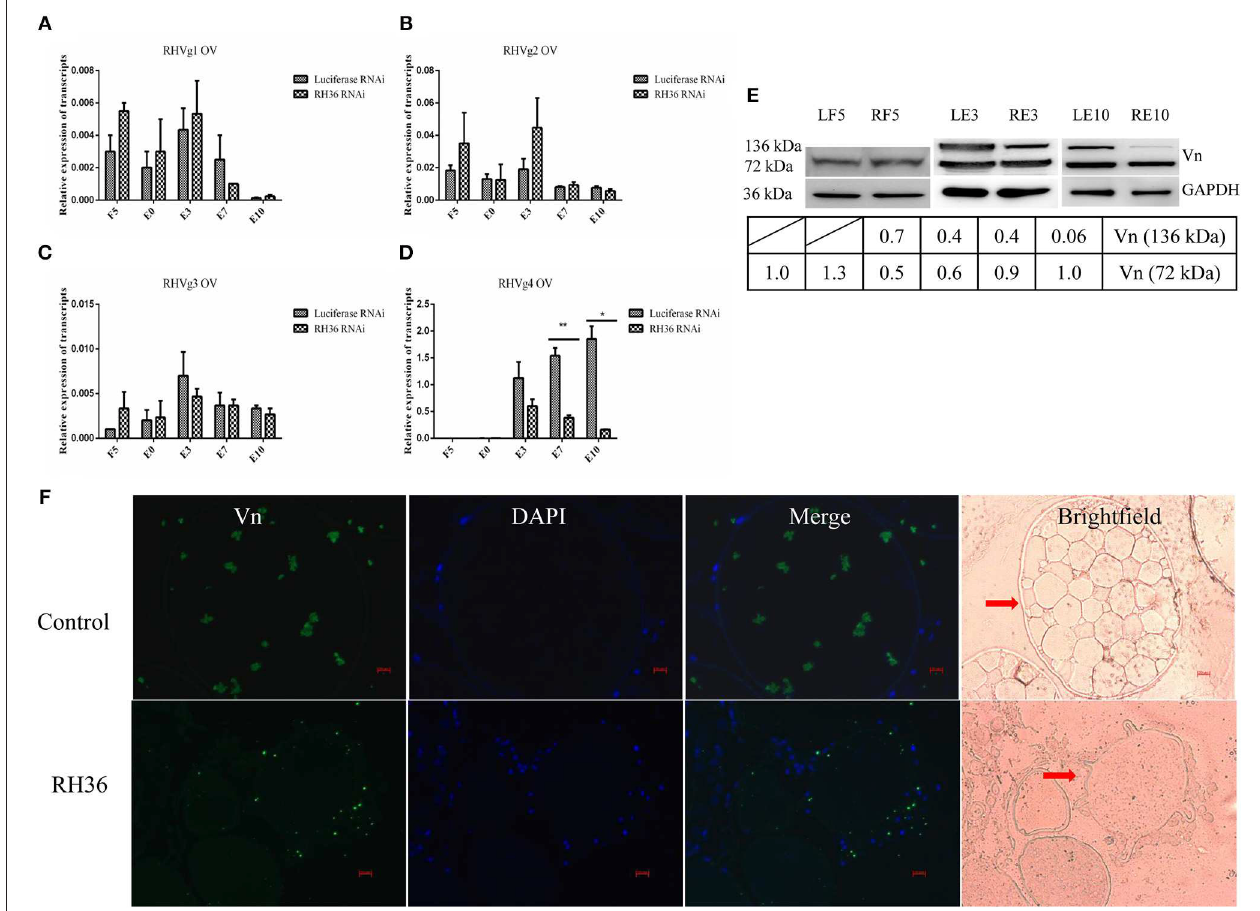
FIGURE 4 | RH36 is involved in expression and/or processing of RHVg genes and vitellin protein after engorgement. Transcript level of RHVg1 (A) , RHVg2 (B) , RHVg3 (C) , RHVg4 (D) genes was tested in the ovaries of adult ticks at 5 days blood feeding, engorgement, 3 days post-engorgement, 7 days post-engorgement and 10 days post-engorgement by real-time quantitative PCR, which shows RHVg4 gene is observably down-regulated at 7 days post-engorgement ( p < 0.01) and 10 days post-engorgement ( p < 0.05). ** means highly statistical significance that P-values less than 0.01. * means statistical significance that p -values less than 0.05. The data were normalized to tick elongation factor 1 α and gene-specific standards were the respective plasmids. Protein level of vitellin reduced in the ovaries at 3 days post-engorgement and 10 days post-engorgement by Western blot (E) . The intensities of vitellin protein bands (136 and 72 kDa) were normalized to GAPDH. RH36 regulates tick ovary development by reducing vitellin uptake in oocytes using immunofluorescence assay (F) . Tick ovaries were collected at 10 days after engorgement from RH36 and luciferase (as control) RNAi groups and stained with mouse anti-vitellin antibodies. Vitellin was observed in green fluorescent and DNA was stained with DAPI (blue fluorescent). Scale bar: 20 µ m. LF5, 5-day-fed ticks from luciferase RNAi groups; RF5, 5-day-fed ticks from RH36 RNAi groups; E0, on the day of engorgement; LE3, 3 days post-engorgement ticks from luciferase RNAi groups; RE3, 3 days post-engorgement ticks from RH36 RNAi groups; E7, at